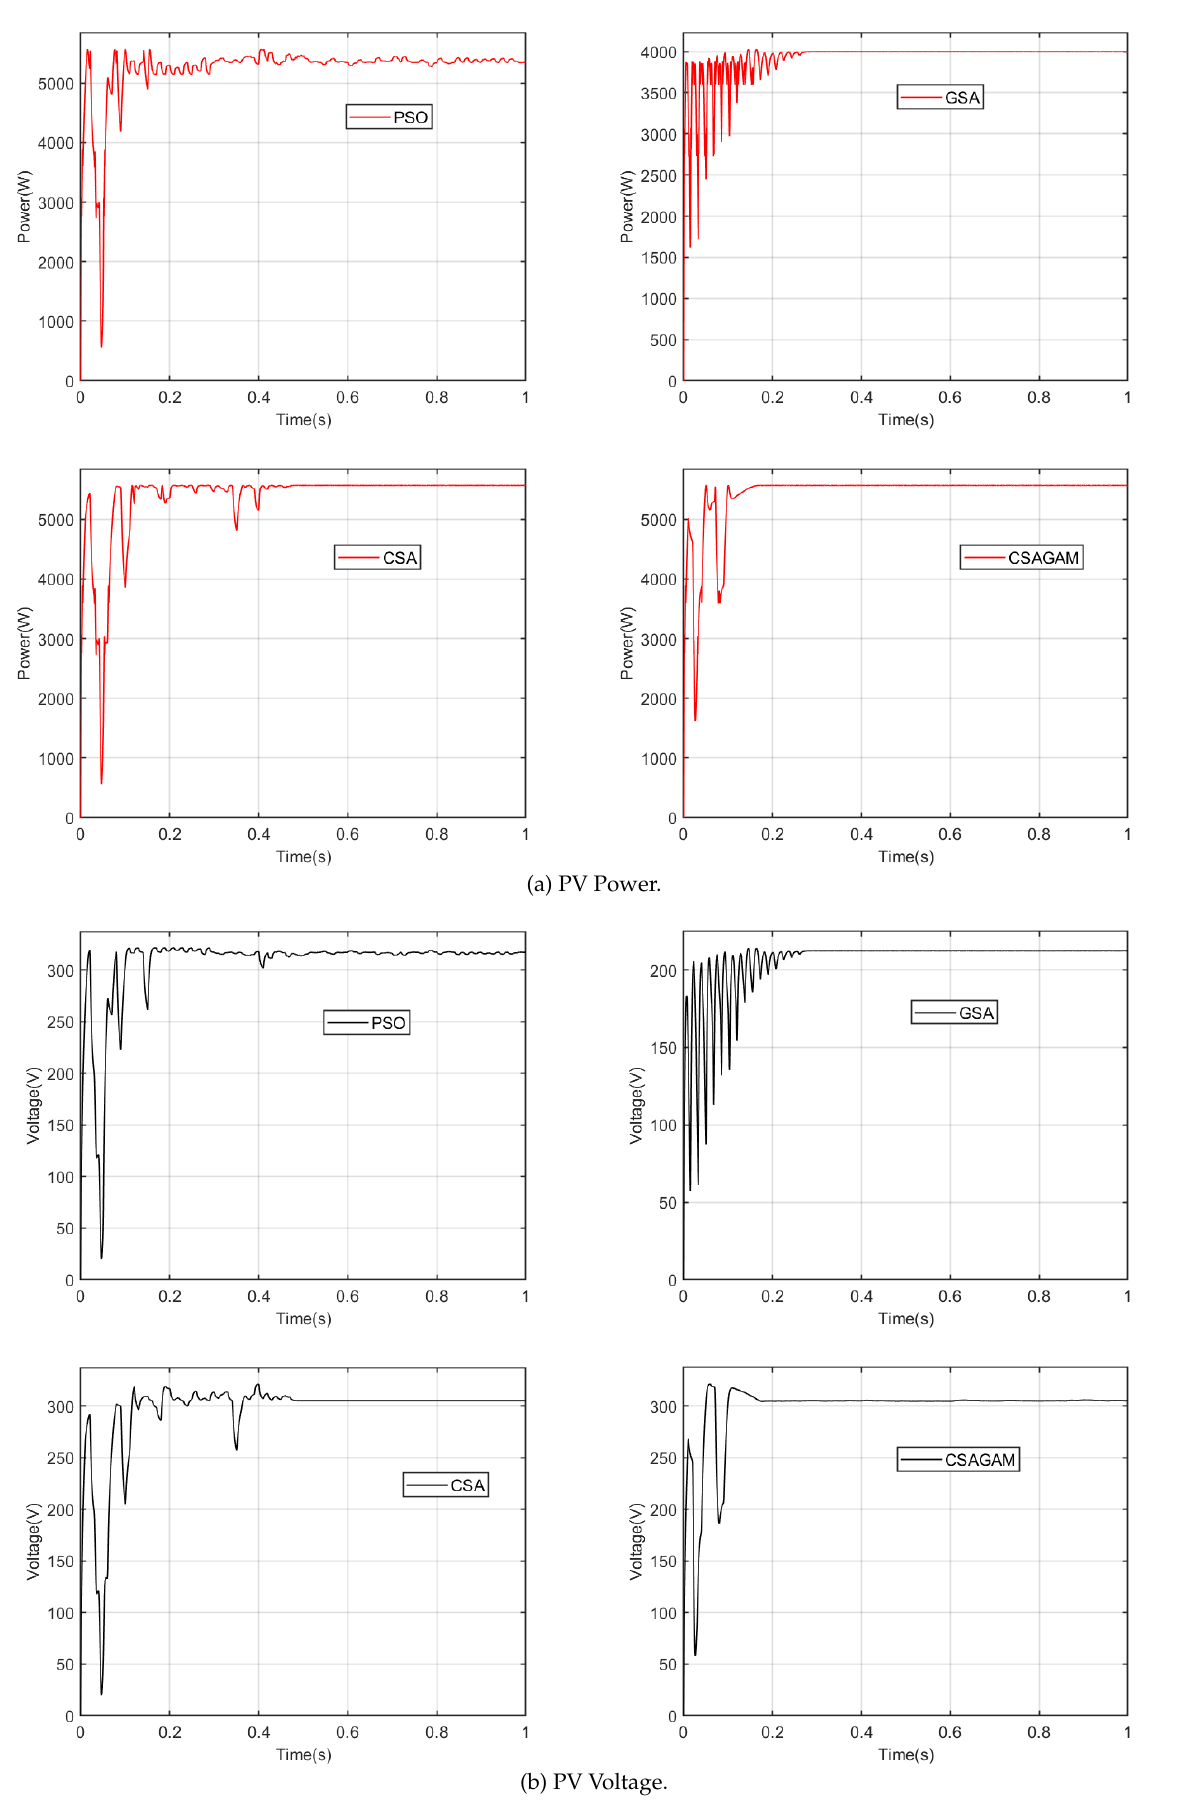
Fig. 6. Simulation results for the first partial shading case PSC